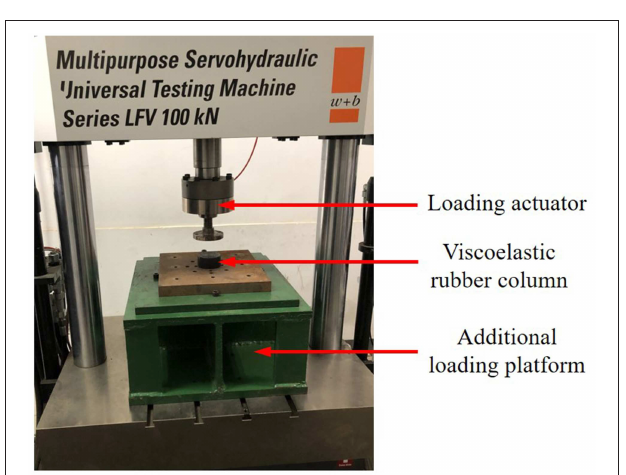
FIGURE 5 | Schematic diagram of test loading device.